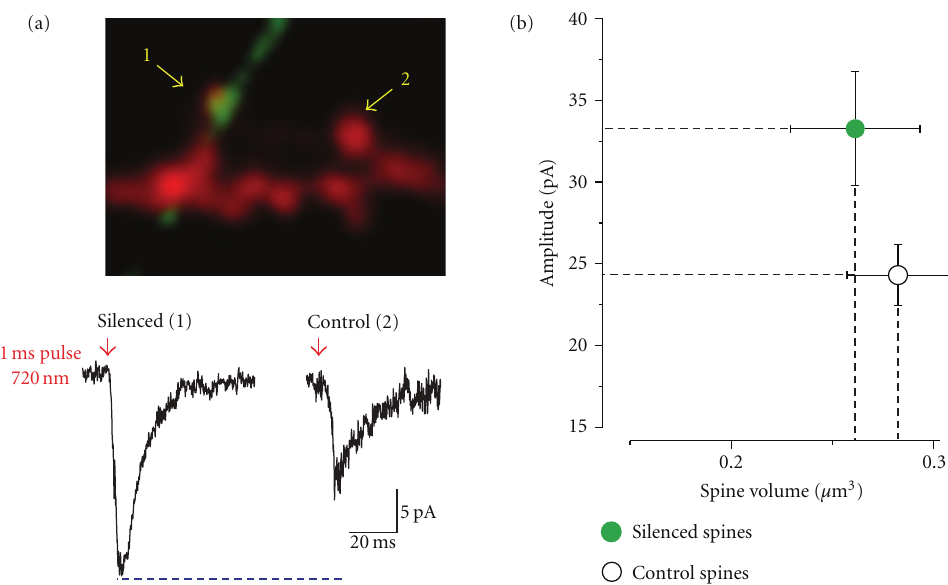
Figure 2: Dissociation of spine size and synaptic strength . (a) The release of glutamate was reduced for 48 hours specifically on the spine marked (1). This leads to a homeostatic enhancement of synaptic strength, as assessed by 2P-uncaging of MNI-Glutamate. The size of the synaptic currents induced by 2P-uncaging is shown in the bottom panel. (b) The significant enhancement of the amplitude of synaptic currents onto “silenced” spines was not accompanied by any measurable changes in spine volume. Adapted from